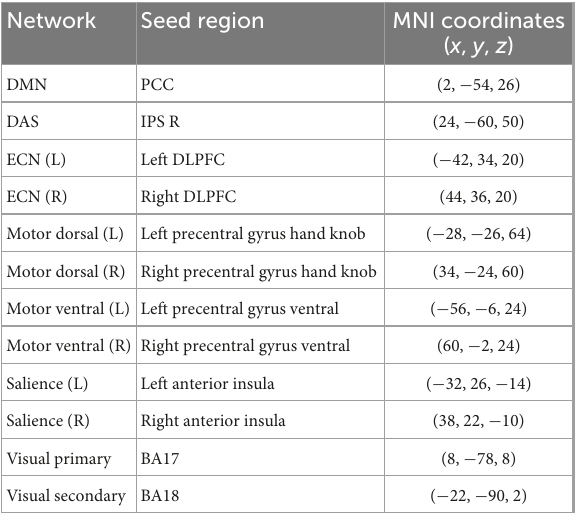
TABLE 1 Seed location of 12 functional networks used in seed-based connectivity analysis.